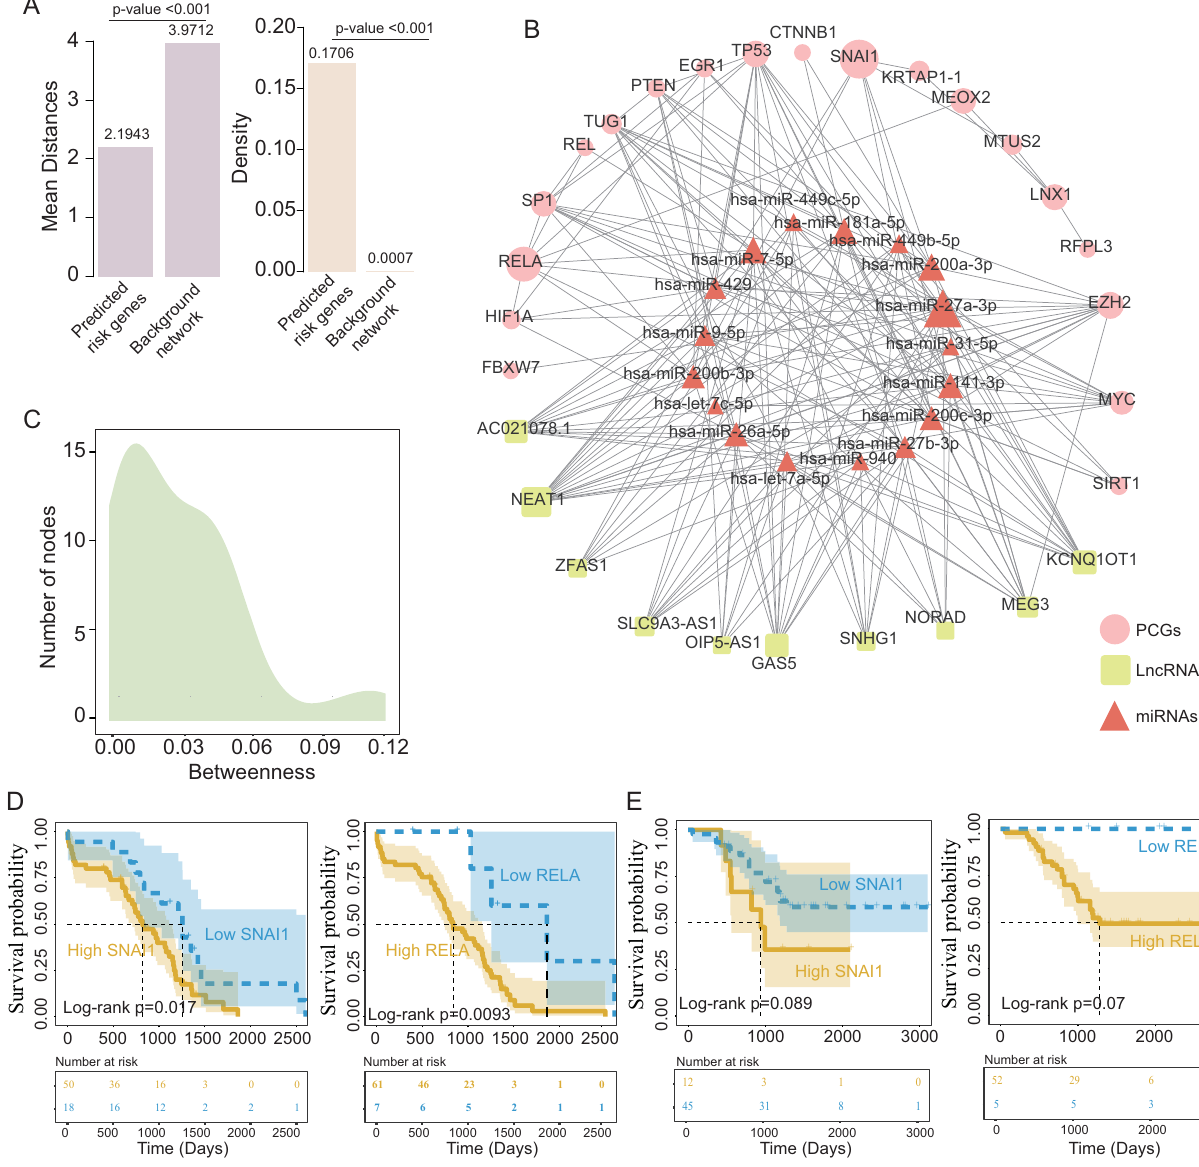
Fig. 5 Network analysis of novel UM-related SGs. A Histogram showing the distribution of mean distances and density of predicted SGs and background network. B Subnetwork of novel UM-related SGs. C Distribution of betweenness of nodes in the subnetwork. UM uveal melanoma, SGs susceptibility genes. lncRNA long non-coding RNA, miRNA/miR microRNA, PCGs protein-coding